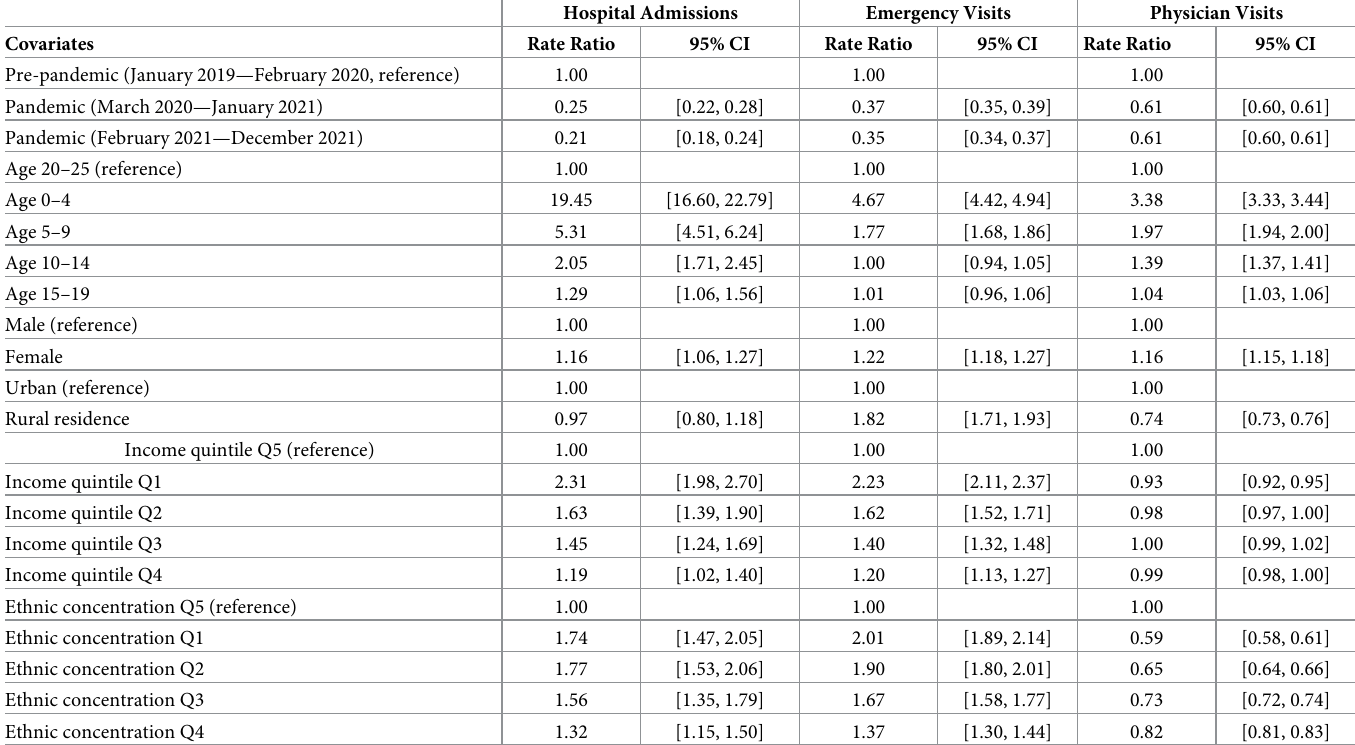
Table 2. Adjusted rate ratios of asthma health services use based on negative binomial